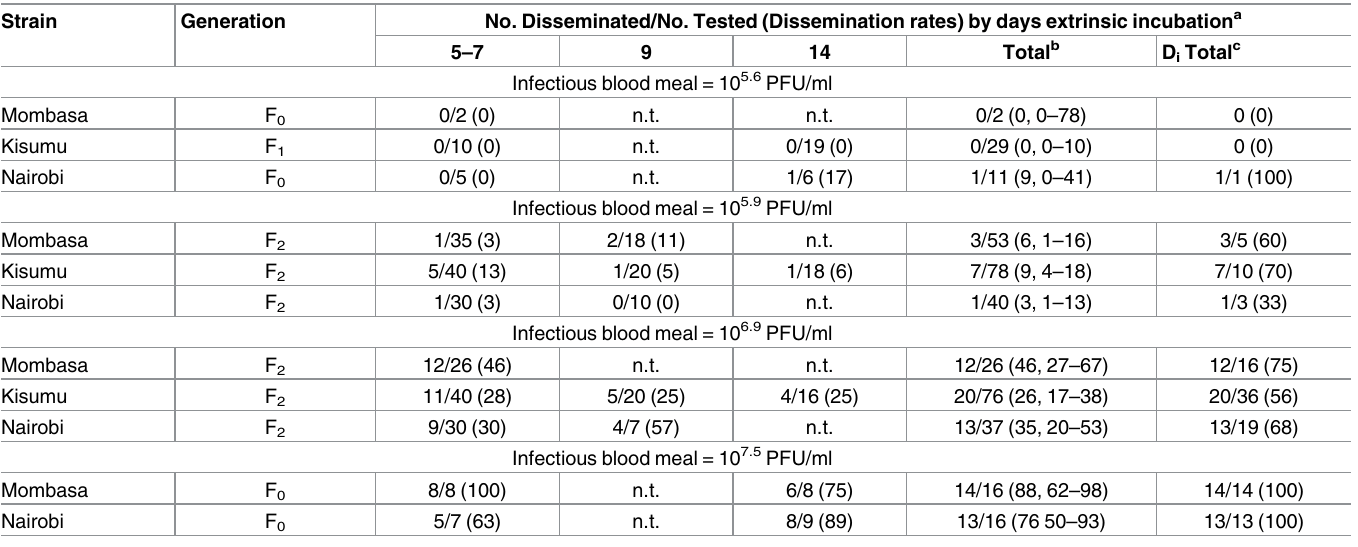
Table 3. Dissemination rates by day after feeding on a chikungunya virus blood meal. Strain